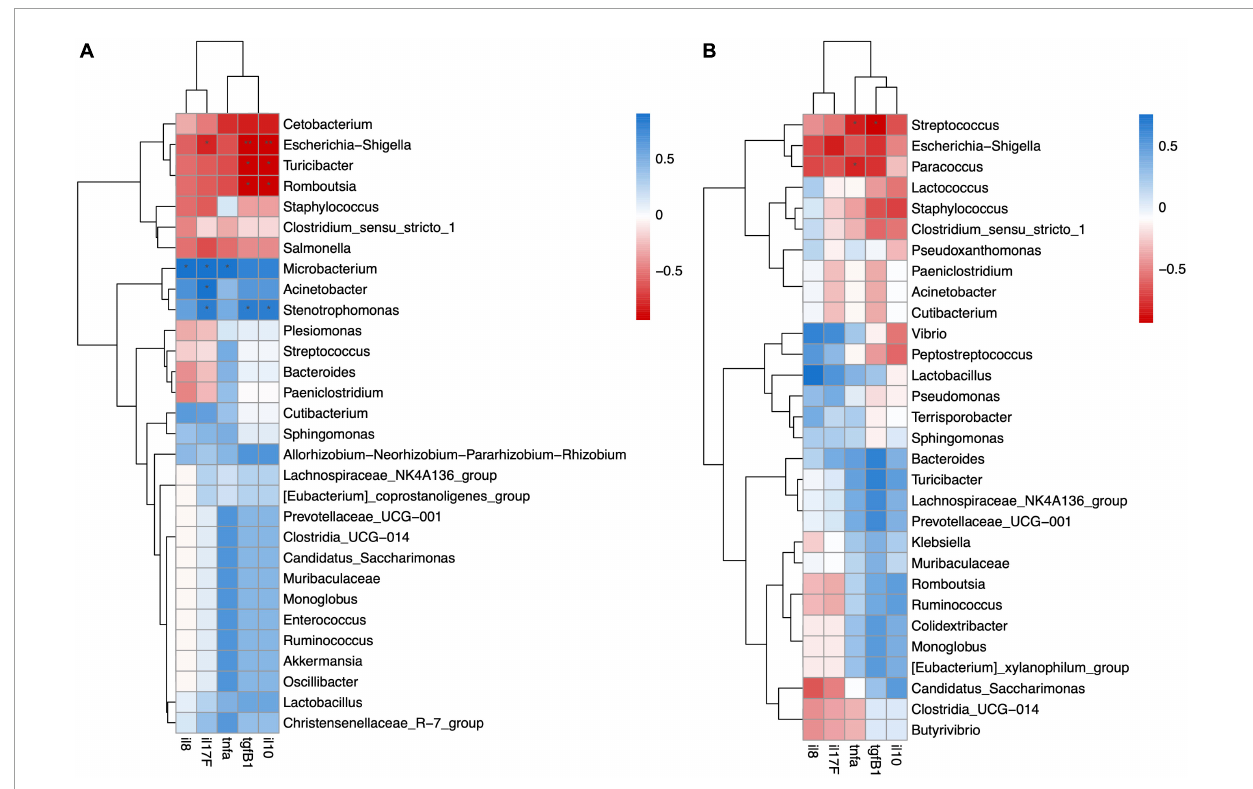
FIGURE7 Spearman correlation analysis revealed significant positive or negative relation between cytokine gene expression and digesta-associated microbiota in (A) FW and (B) SW